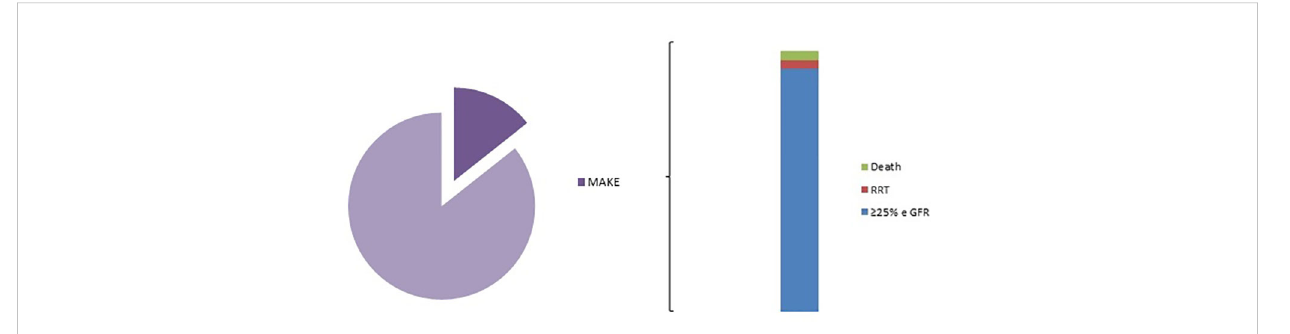
FIGURE 2 MAKE distribution. MAKE, major adverse kidney events. RRT, Renal Replacement Therapy; e GFR, estimated glomerular fi ltration rate.